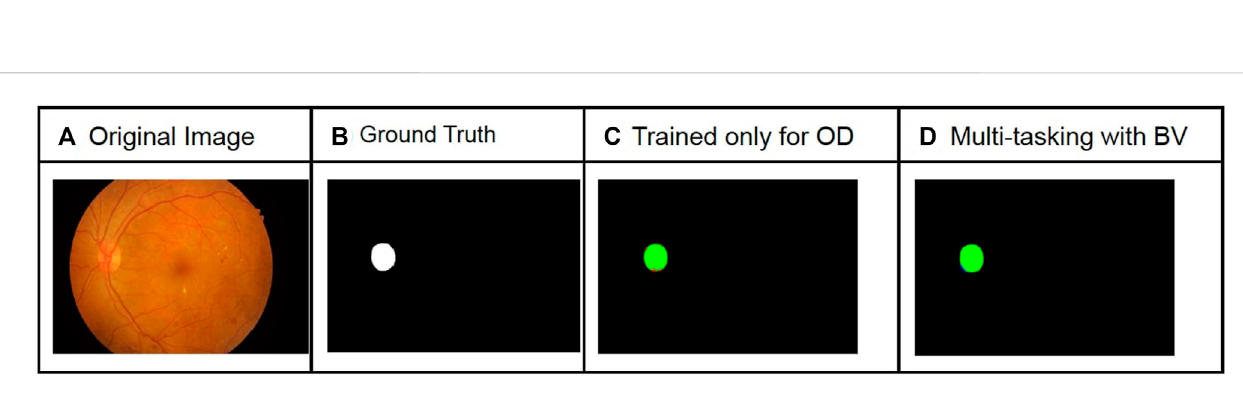
FIGURE 6 Comparison ofopticdiscsegmentationresultsfortheIDRiDdatasetwithandwithoutmulti-tasking.Thegreen pixelsinthepredicted imagecorrespond to true positives, blue pixels correspond to false positives, and red pixels correspond to false negatives. An increase in F1 score of 9% was observed. The columns from left to rightshow original image (A) , Ground Truth (B) , Prediction with model trained only for OD segmentation (C) and Predictionusing model trained with OD and BV segmentation (D)